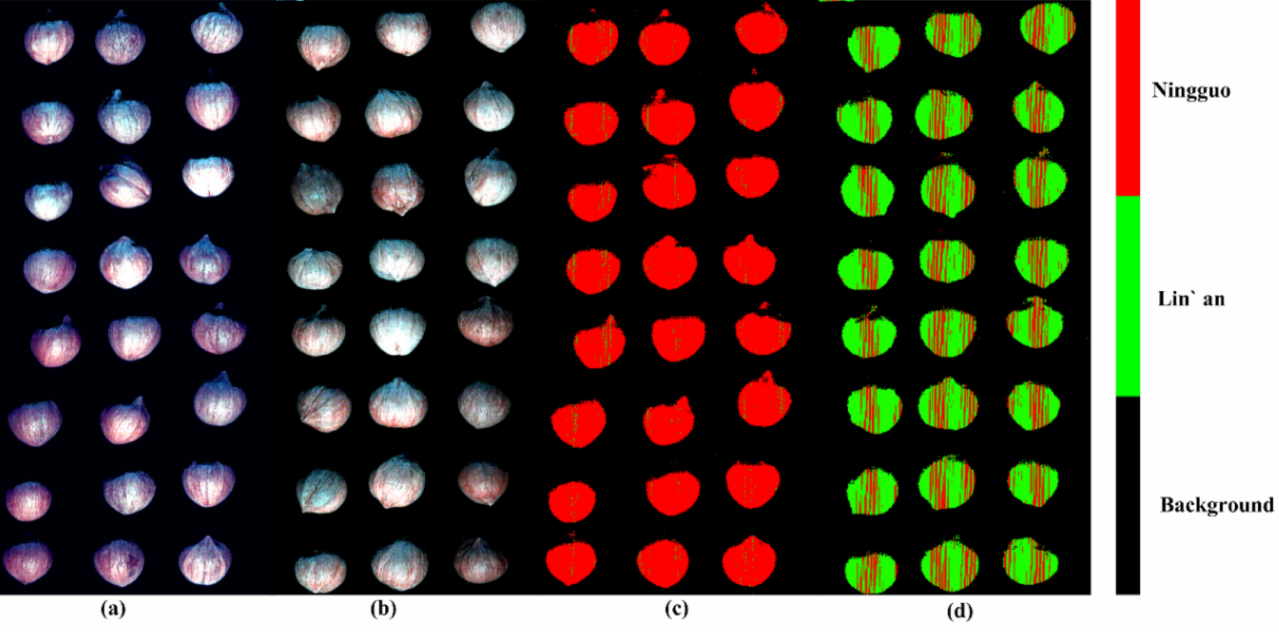
Figure 5. Classification visualization of Ningguo and Lin’an walnut varieties, ( a ) false-color images of Ningguo walnuts, ( b ) false-color images of Lin’an walnuts, ( c ) classification maps of Ningguo walnuts, and ( d ) classification maps of Lin’an